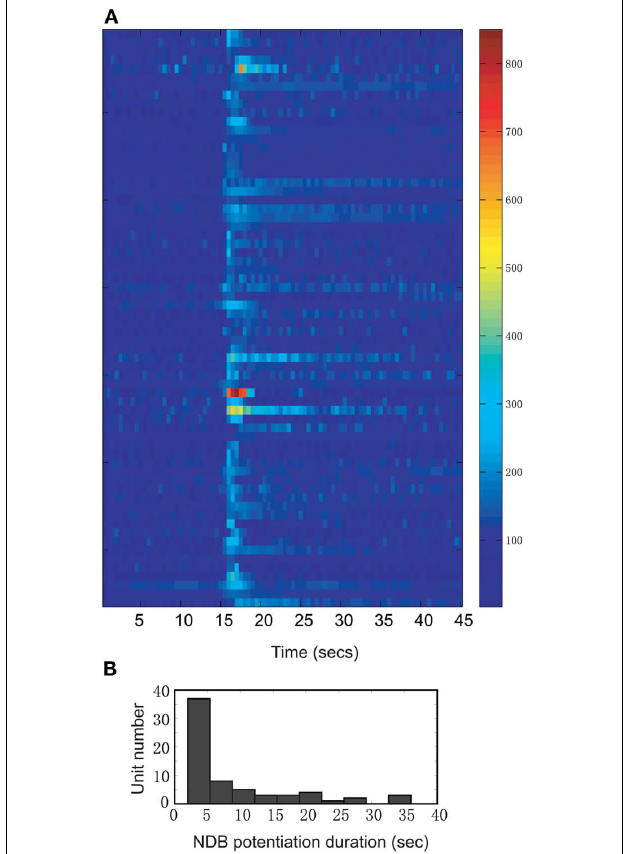
FIGURE 2 | A summary of all units showing increased firing rate following electrical stimulation ( n = 66; Bin = 0.5s). (A) The time course records are normalized to the baseline period 12–15s. The color bar on the right indicates the normalized spike rates (%). (B) Distribution of NDB potentiation shows the range of duration from 2 to